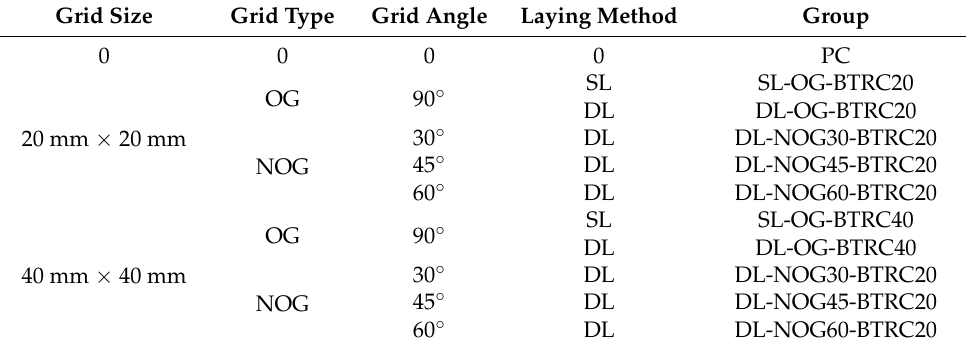
Figure 3. BTRC plate specimen. Division of four-point bending test area of test specimen ( left ); schematic diagram of four-point bending test ( right ). Table 4. Specimen